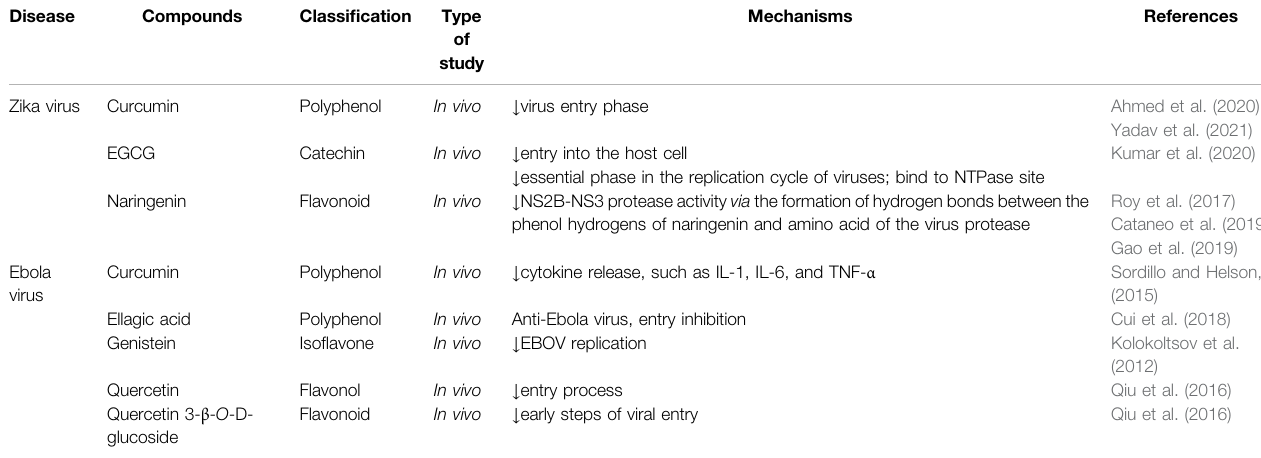
TABLE 3 | Some preclinical evidence on the use of candidate phytochemicals against ZIKV and EBOV and neuropharmacological responses. Disease